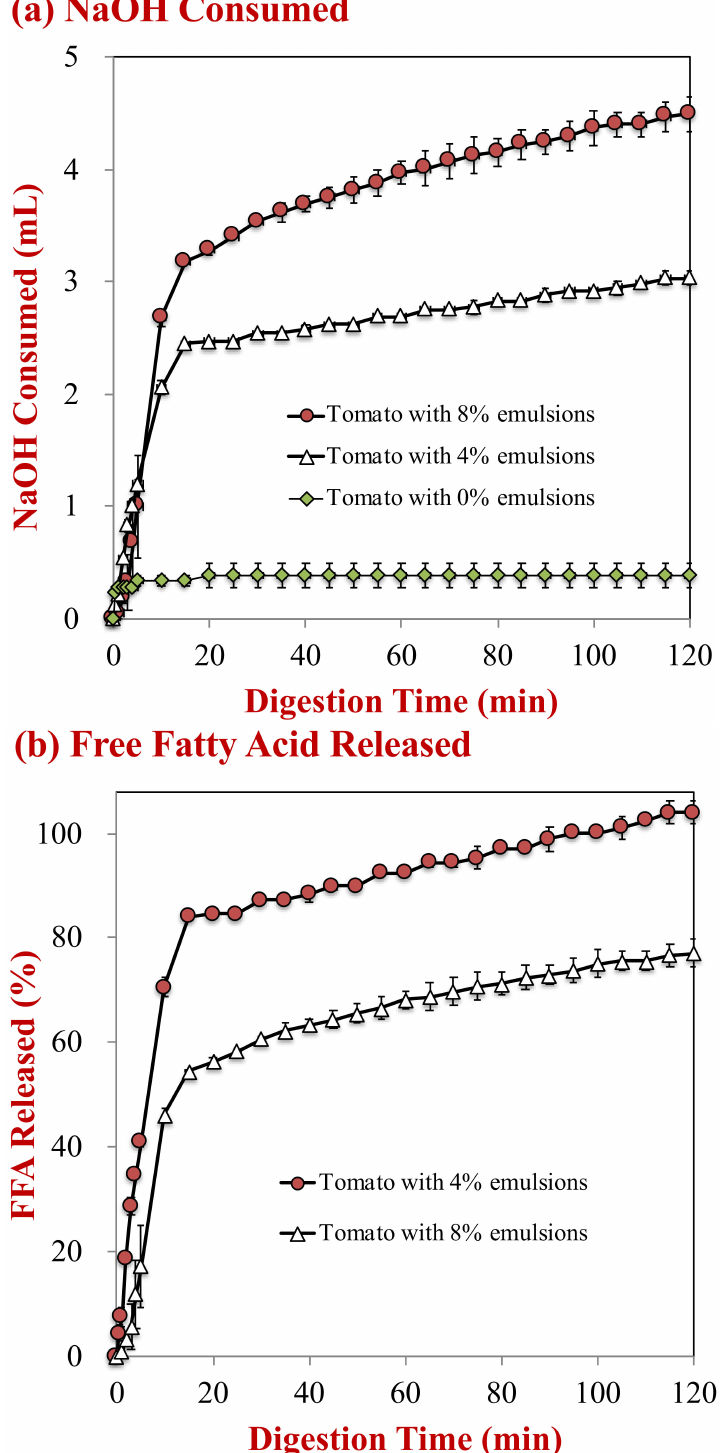
Figure 5. Digestion profiles of samples with di ff erent lipid contents during simulated digestion in the small intestine: ( a ) Amount of NaOH consumed; and, ( b ) the fatty acid release